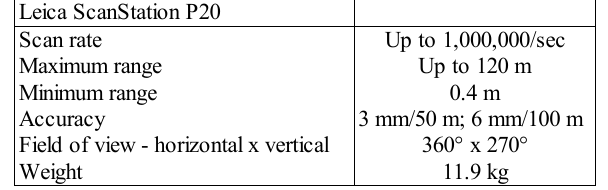
Table 16. Leica ScanStation P20